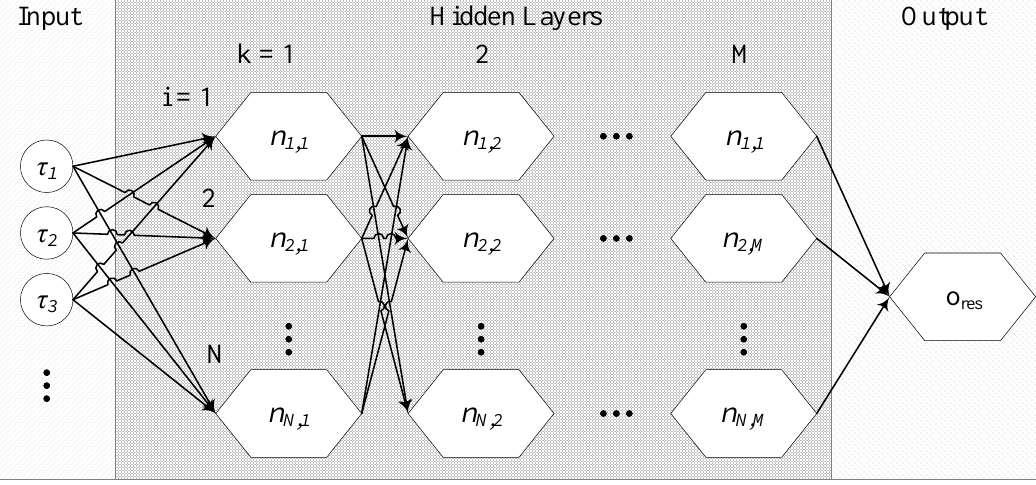
Figure 2. Schematic of an artificial neural